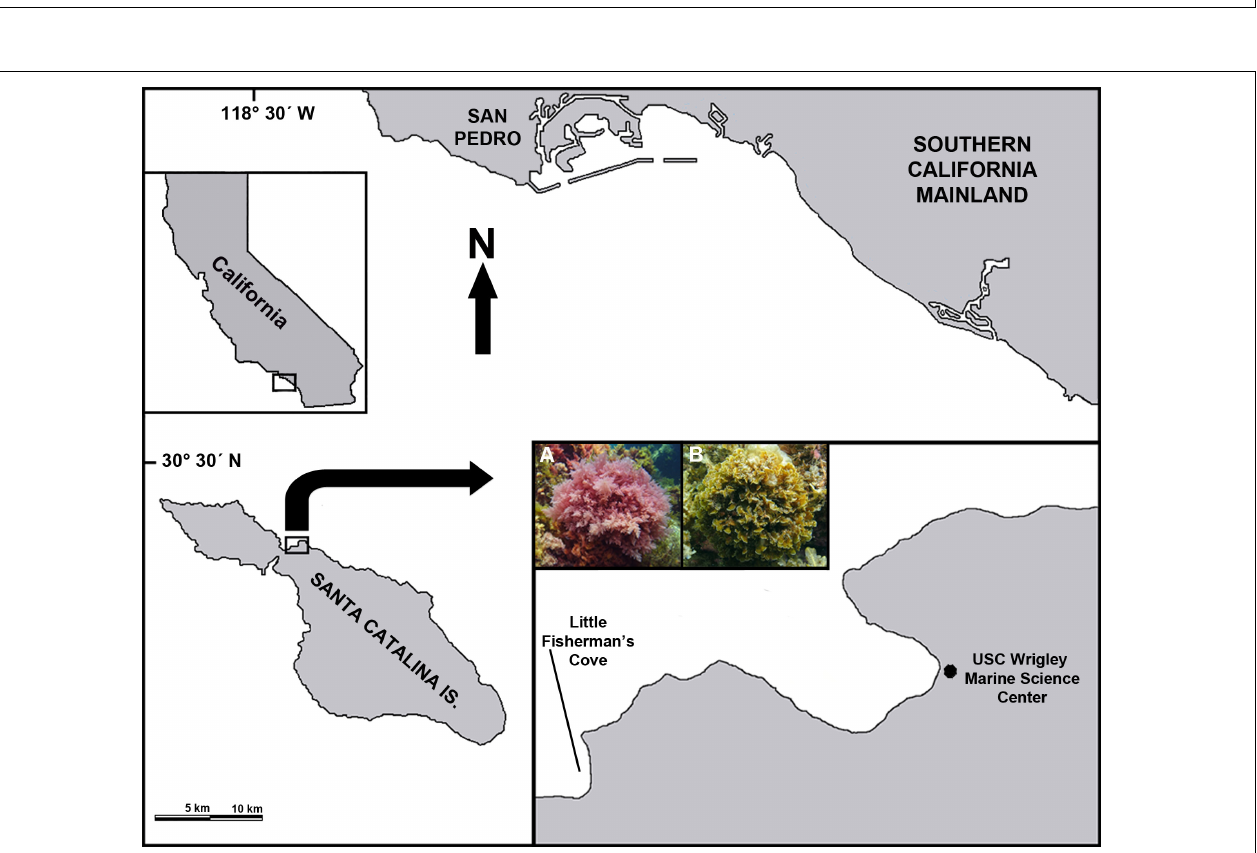
FIGURE 1 | Experimental design. Rumen content was collected from a rumen fistulated Holstein cow and rumen fluid was diluted threefold with saliva buffer after rumen solids and fluid were separated. Fluid/buffer mixture was amended with rumen solids and Super Basic Ration. To test effect of Asparagopsis taxiformis and Zonaria farlowii , fermentation vessels were supplemented with 5% dry matter (DM) of the corresponding seaweed. Carbon dioxide (CO 2 ), methane (CH 4 ) production and volatile acid profiles were determined after 24 and 48 h.